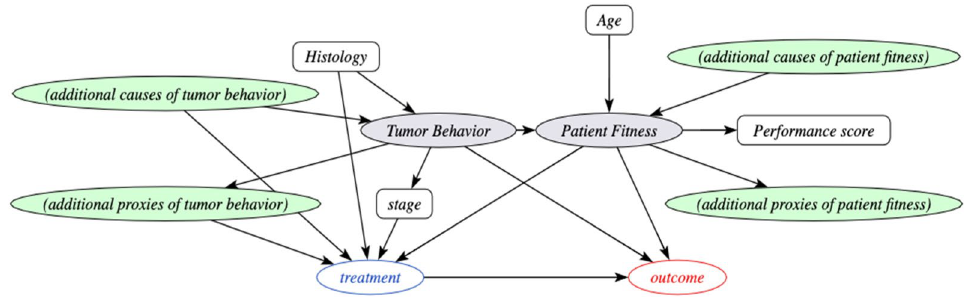
Figure 1. The behavior-fitness causal Directed Acyclic Graph (DAG) scaffold for cancer treatment decisions. Circles indicate variables, grey-shaded variables are unobserved. Arrows point from a cause variable to an effect variable. Tumor behavior and patient fitness are unobserved variables that induce correlations between the observed variables. The definition of the treatment variable and potentially the outcome variable vary per cancer setting. Depending on the specific situation, relevant additional cause variables and effect variables for tumor behavior and patient fitness should be selected. Estimating the effect of the treatment on the outcome (potentially conditional on the other variables in the DAG) is the target application of PROTECT. The presence of the unobserved confounder fitness implies that conventional confounding adjustment methods cannot be used to estimate treatment effects from observational data, whereas the proposed method PROTECT can. Filling in additional proxies and causes of tumor behavior and patient fitness in this DAG is the first step of PROTECT. PROTECT proxy based individual treatment effect modeling in